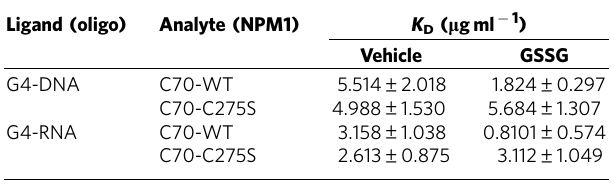
Figure 6 | NPM1 dissociates from rRNA/rDNA after exposed to oxidized GSH in vitro . SPR analysis of the interaction of NPM1-C70 (WTor C275S, as analyte) and G-quadruplexes (rDNA (upper) or rRNA (bottom), as ligand). Different colourful traces referred to increasing analyte concentrations ( m gml (cid:2) 1 ). The dissociation constant ( K D ) values were calculated with a one-site steady state binding model (see Supplementary Fig. 5g and Table 1). GSSG, oxidized GSH. G4, G-quadruplex. Table 1 | The K D values of the interactions of rRNA or rDNA G-quadruplexes with NPM1-C70 WT or C275S mutants